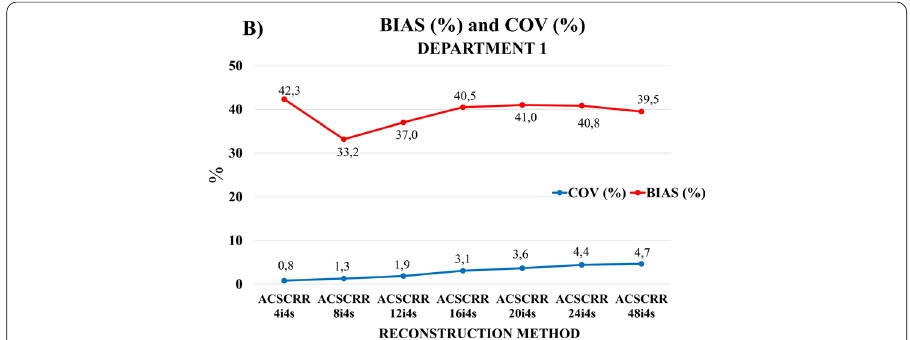
Fig. 9 BIAS and COV plot showing average BIAS values of spheres activity concentration and COV average values for background, in the NEMA/IEC NU2 Body Phantom cross sections reconstructed with 7 methods compliant with the paper by Gnesin et al. [11]. The calculations were made with the Q.Metrix program for images acquired with Discovery NM/CT 670 at Department 1